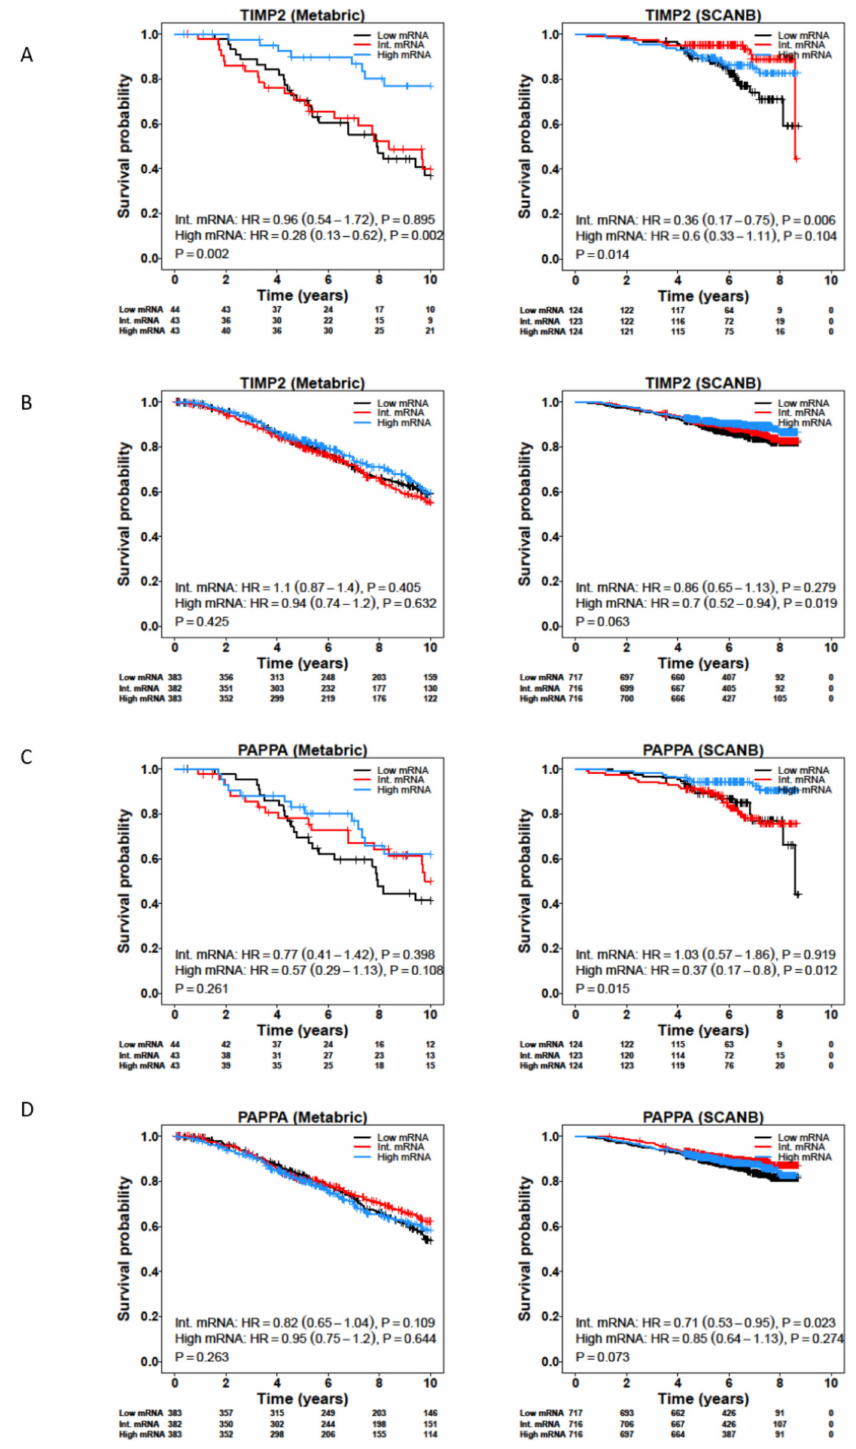
Figure 4. Expression of TIMP2 and PAPPA is associated with better survival in ILC patients. Kaplan– Meier plots for overall survival for TIMP2 in ER+ ILC ( A ) and IDC ( B ), and PAPPA in ER+ ILC ( C ) and IDC ( D ) tumors from the METABRIC and SCAN-B studies. Patients were divided into tertiles based on their TIMP2 and PAPPA mRNA